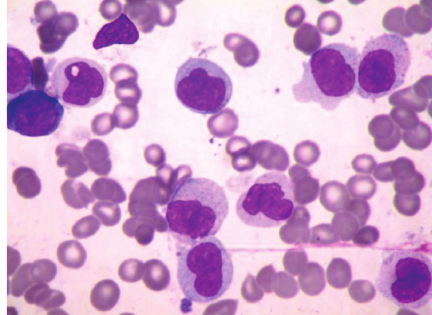
Figure 2: Severe macrocytic anemia with prominent rouleaux and dimorphism. WBC: severe neutropenia with absolute monocytosis. Fair number of immature cells.